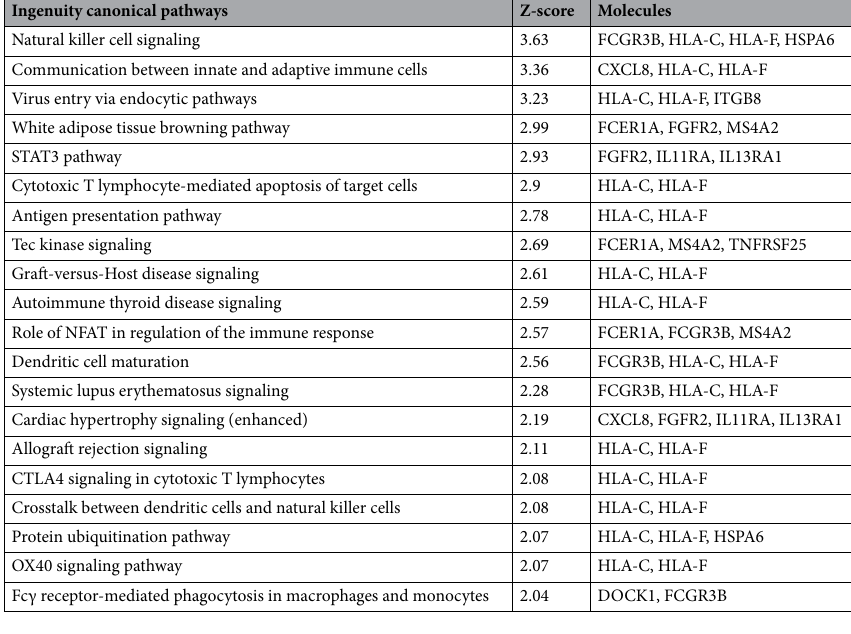
Table 3. Annotated categories of diseases and functions from IPA.